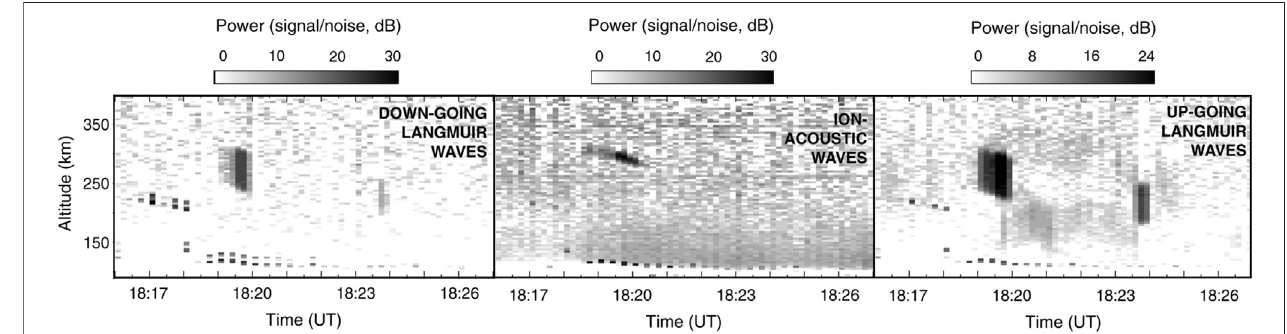
FIGURE 8 | Adapted from Isham et al. (2012): Range-Time-Intensity plot of received power associated with ion-acoustic (middle) and down- and up-going Langmuir waves (left and right, respectively) obtained by the EISCAT 224-MHz radar on November 11, 1999. The simultaneous ampli fi cation of ion-acoustic and Langmuir waves is a signature of Langmuir